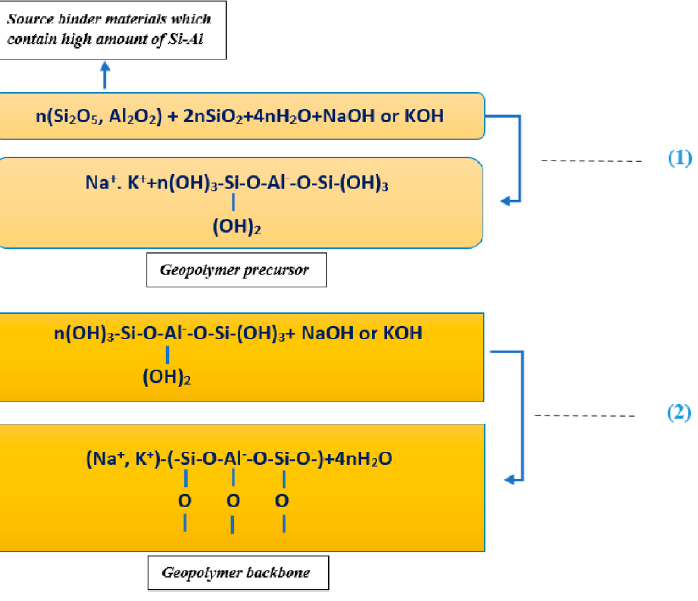
Figure 6. Various stages of geopolymerization process [147].